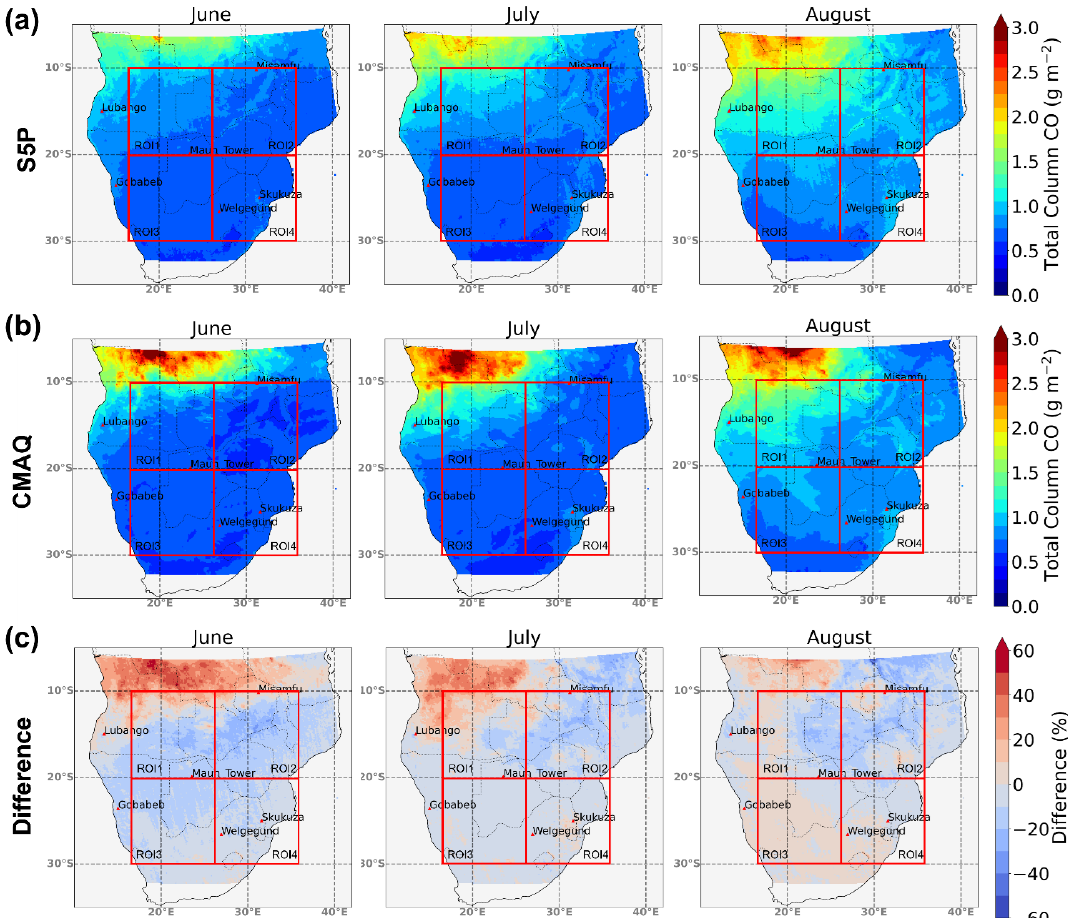
Figure 9. Mapped mean monthly total column carbon monoxide (TCCO) between 15 June and 29 August 2019, as determined by (a) S5P observations typically observed between 12:00 and 14:00UTC and (b) CMAQ-averaged model TCCO output between 12:00 and 14:00UTC; the model is fed with the FREMs_bCO emissions inventory developed herein. Their percentage difference is shown in (c)